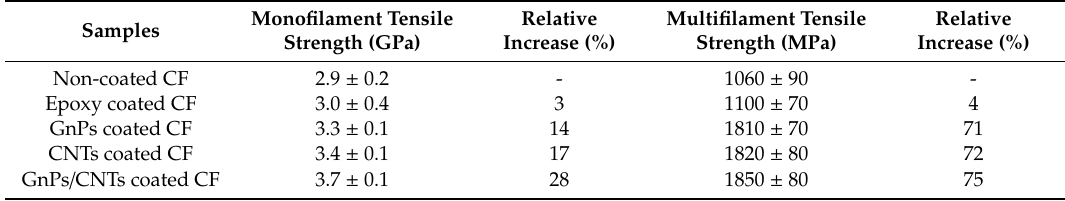
Table 1. The monofilament and multifilament tensile strength of carbon fiber reinforcement epoxy composites (CFRP) composites.